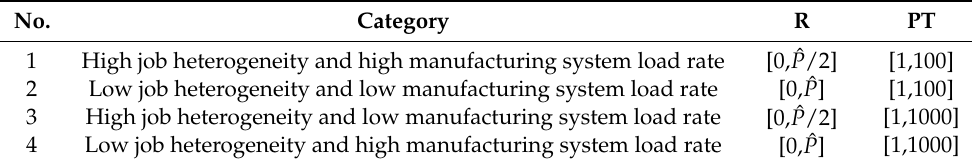
Table 7. Attribute value ranges of a job in the manufacturing system.